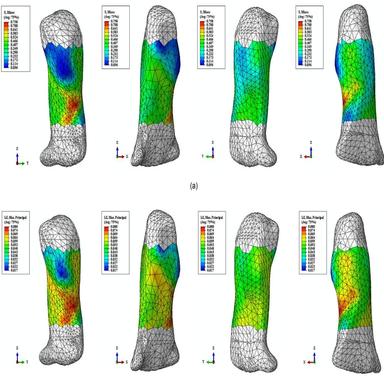
Finite element models of an ACL with hyperelastic material properties showing (a) von Mises stress (S, Mises) and (b) maximum principal logarithmic strain (LE, Max, Principal) across the surface at different views. (For interpretation of the references to color in this figure legend, the reader is referred to the web version of this article.)